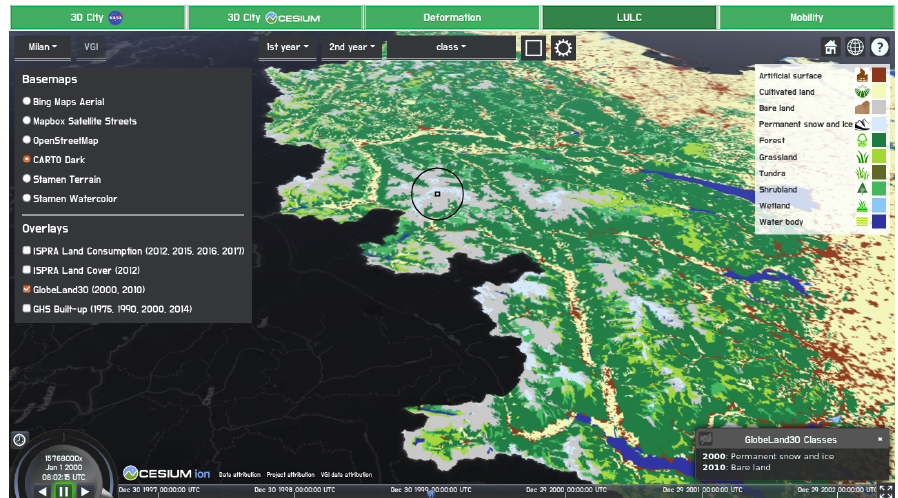
Figure 11. Query of a pixel of GlobeLand30 for 2000 and 2010 on a virtual globe created using